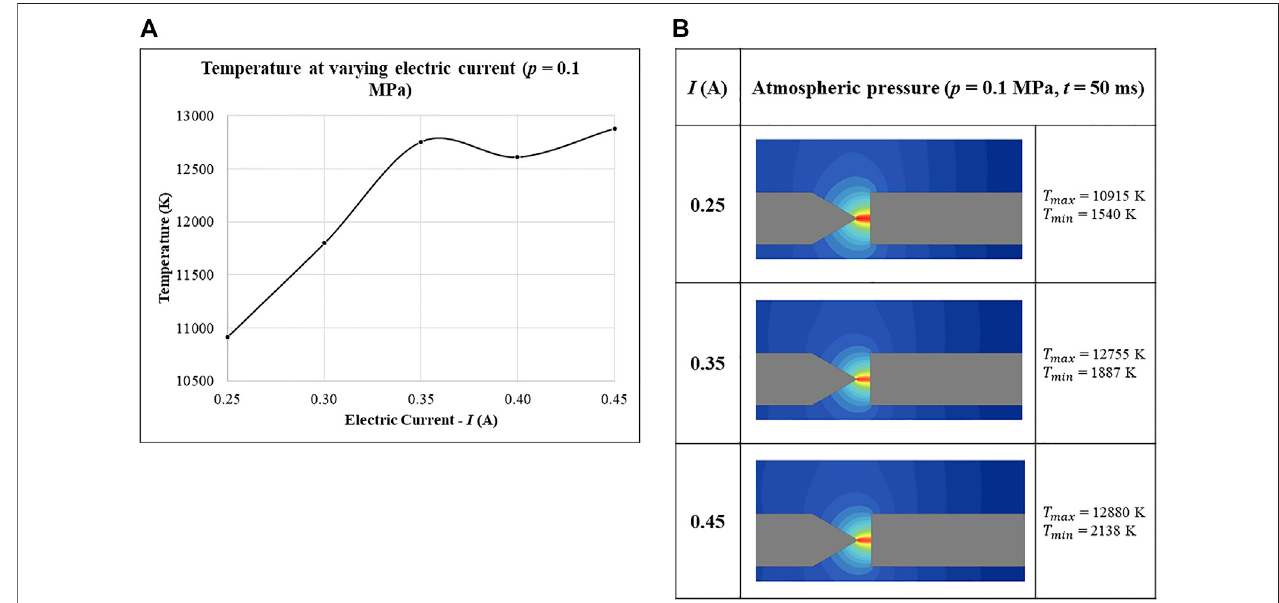
FIGURE 13 | (A) Temperature in the x axis direction at the center of the inter-electrode gap for varying current, (B) Images of the arc discharge temperature at varying current; ( t (cid:2) 50 ms, p (cid:2) 0.1 MPa).